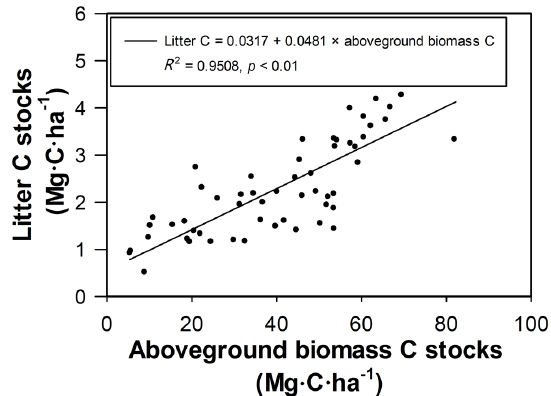
Figure 4. Correlations between the aboveground biomass (trees and understory) C stocks and litter C stocks of the forests.